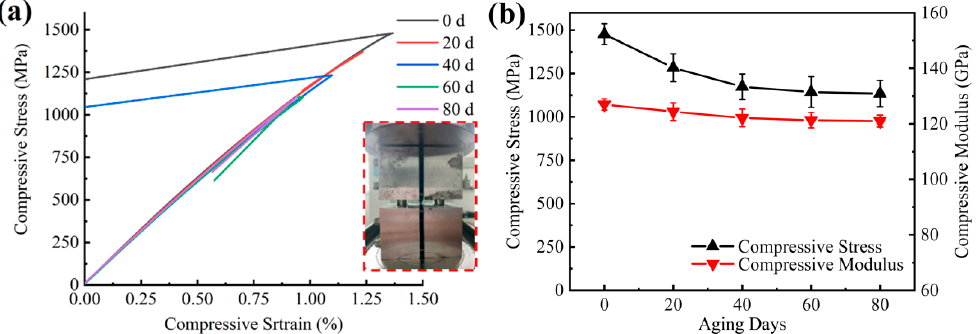
Figure 15. ( a ) Longitudinal direction compression stress–strain curve; ( b ) longitudinal direction compression strength/modulus versus UV aging time curve.